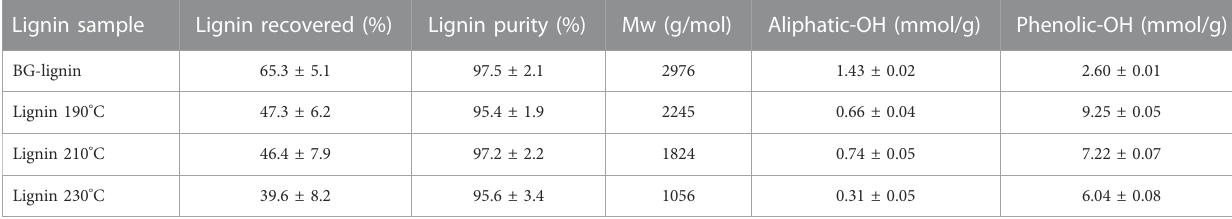
TABLE 1 Characteristics and recovery yield of organosolv lignin extracted from bagasse before and after thermal modi fi